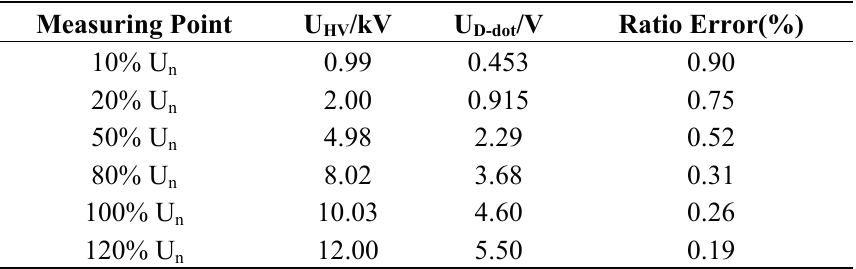
Table 2. Accuracy test result of D-dot sensor.